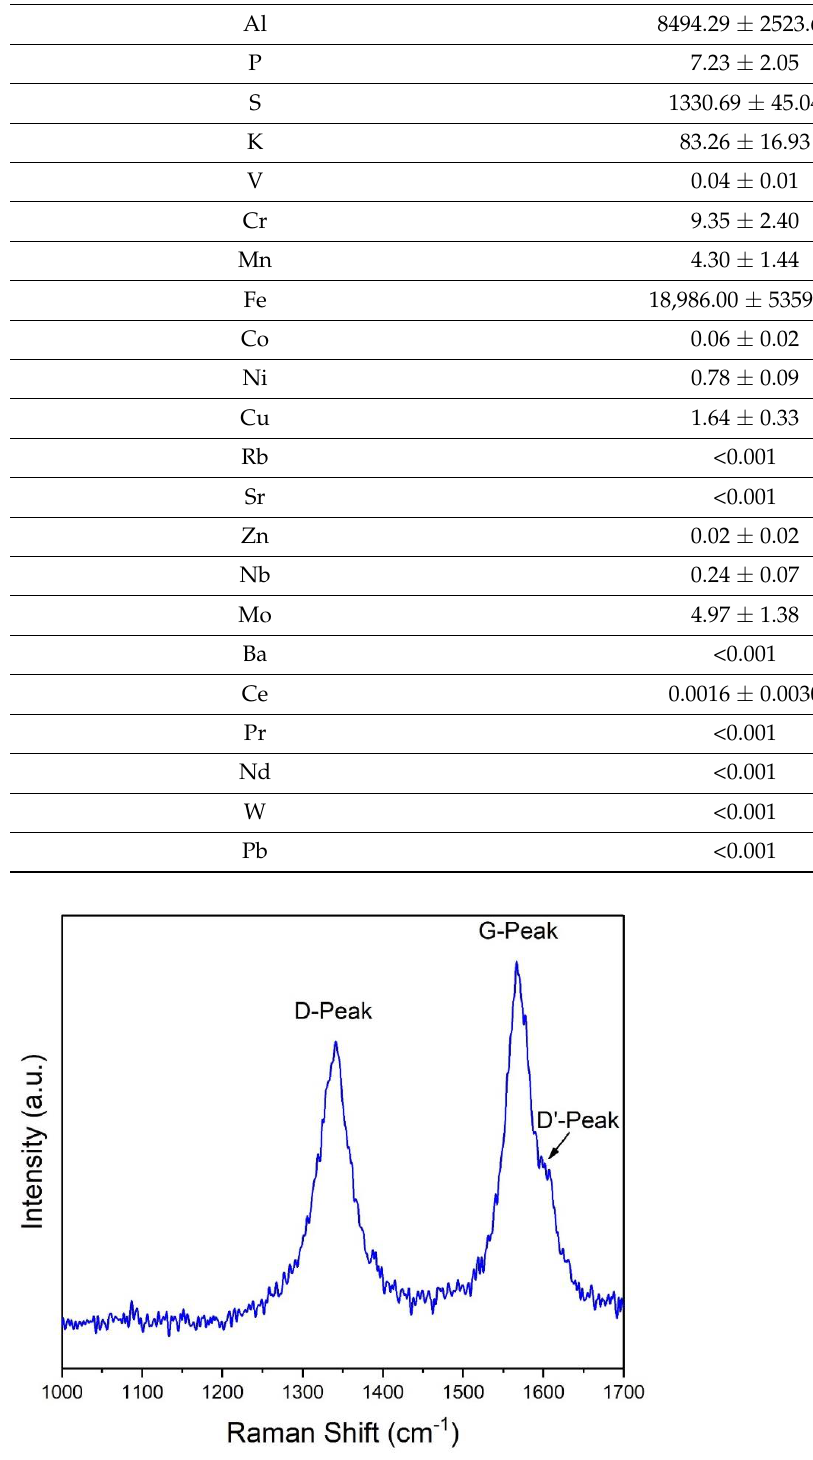
Figure 2. Raman spectra in the range 1000–1700 cm − 1 . Characteristic peak of the crystalline structure of the sample can be observed at 1570 cm − 1 (G-peak); the peaks at 1339 cm − 1 and ~1601 cm − 1 (D-Peak and D’-Peak, respectively) indicate the presence of defects on the surface of the sample.